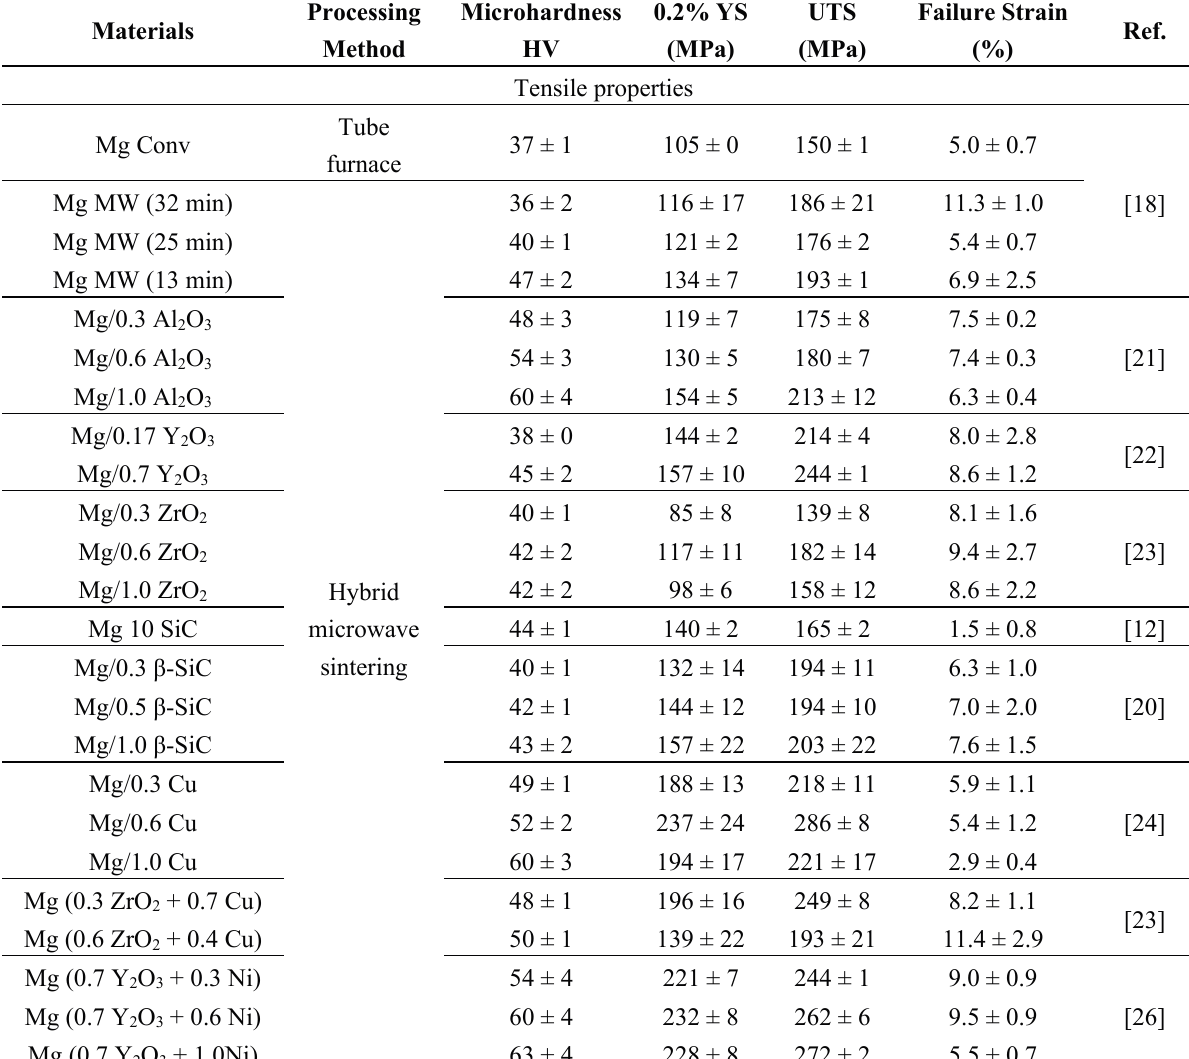
Table 4. Selected mechanical properties of magnesium